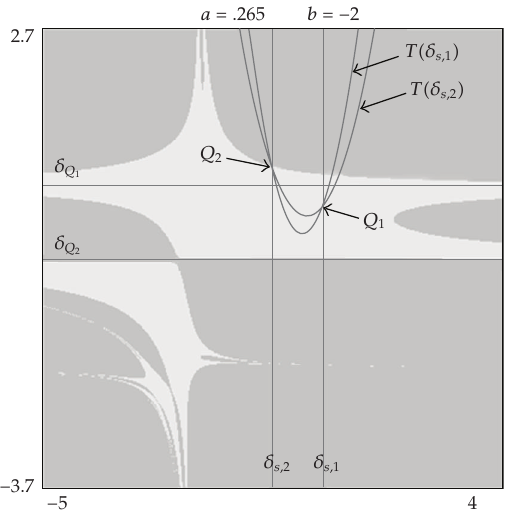
Figure 5: a (cid:2) 0 . 265 basin of attraction non